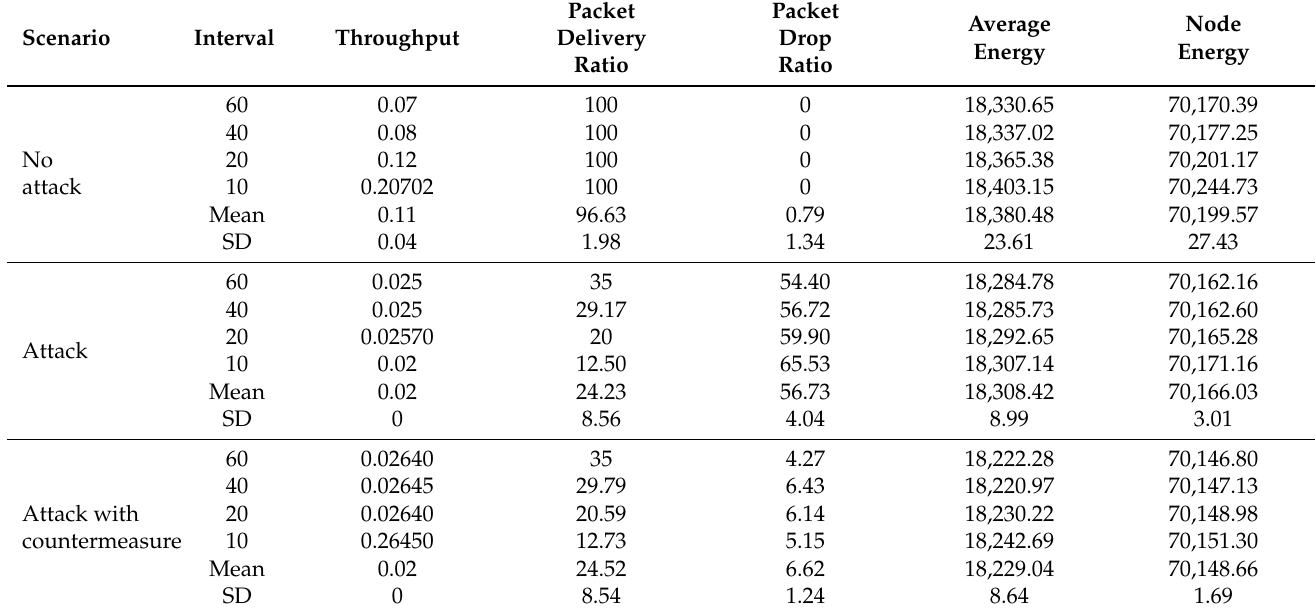
Table 5. Results of the simulation (no-attack, buffer reservation attack, countermeasure with buffer reservation